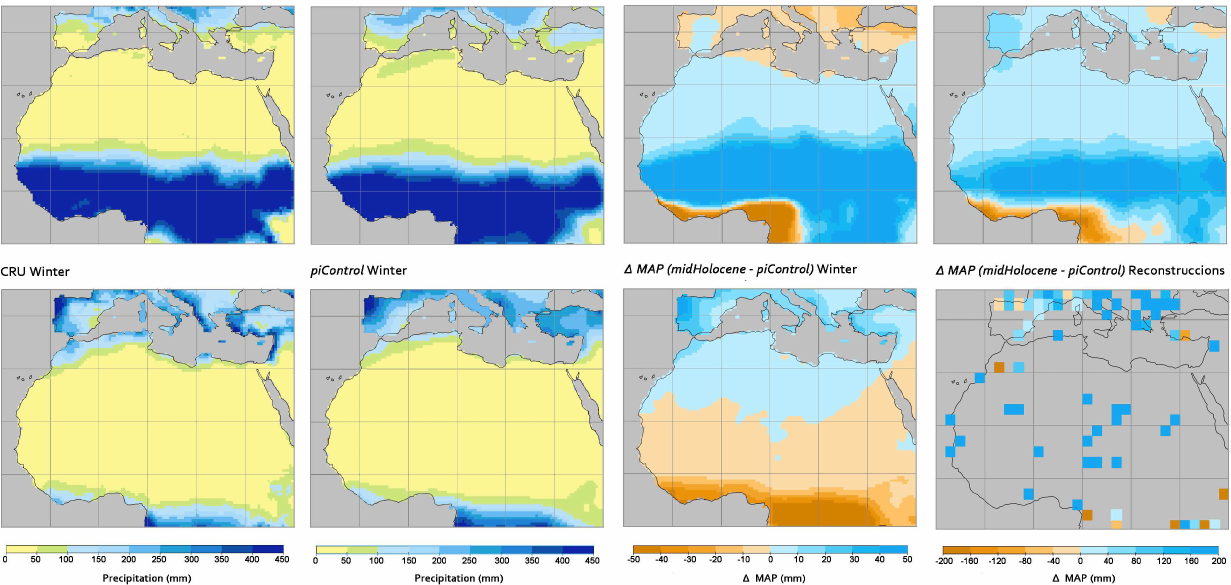
Clim. Past, 10, 551–568, 2014